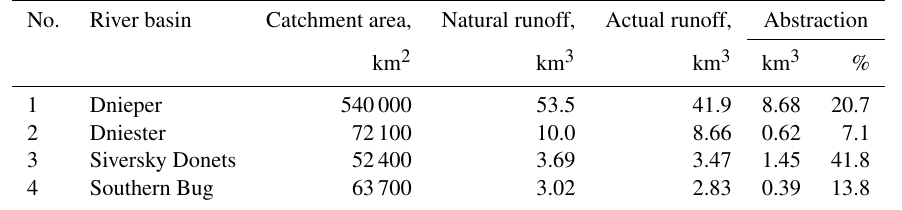
Table 3. Water abstraction from the river basins of Ukraine. No. River basin Natural